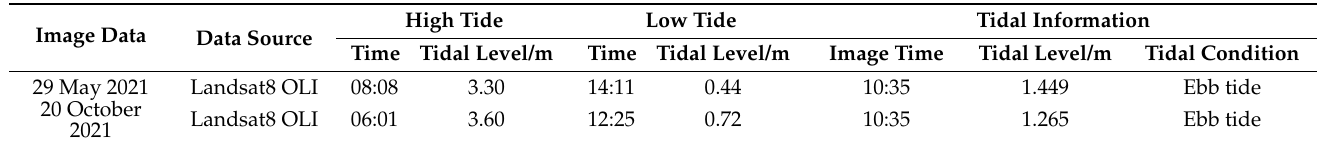
Figure 3. Principle of tidal correction.